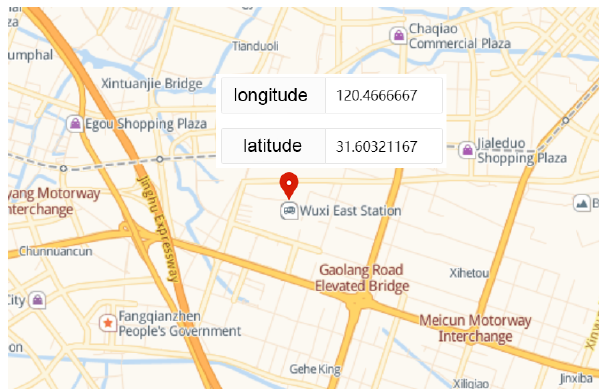
Figure 15. GPS spoofing location.